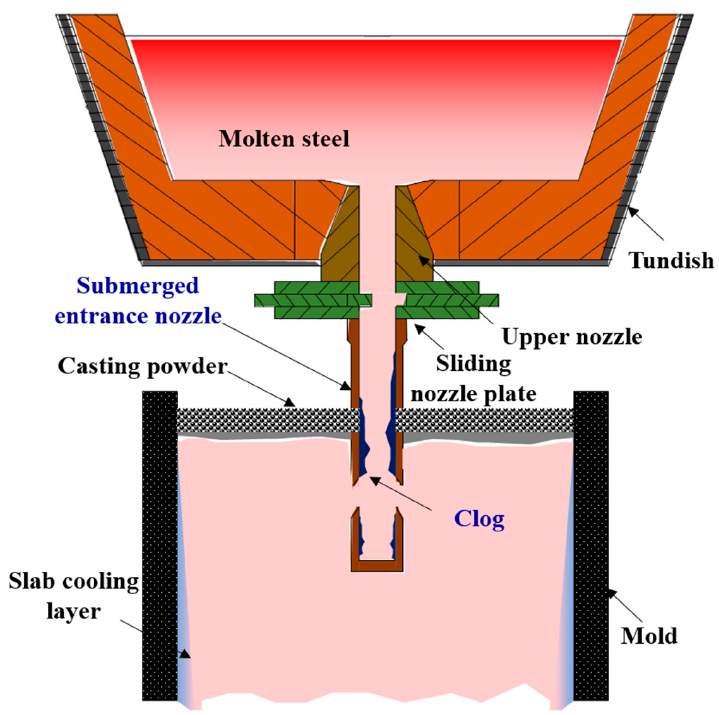
Figure 5. Schematic of the clog formation on the inner wall of the outlet of the submerged entrance nozzle.